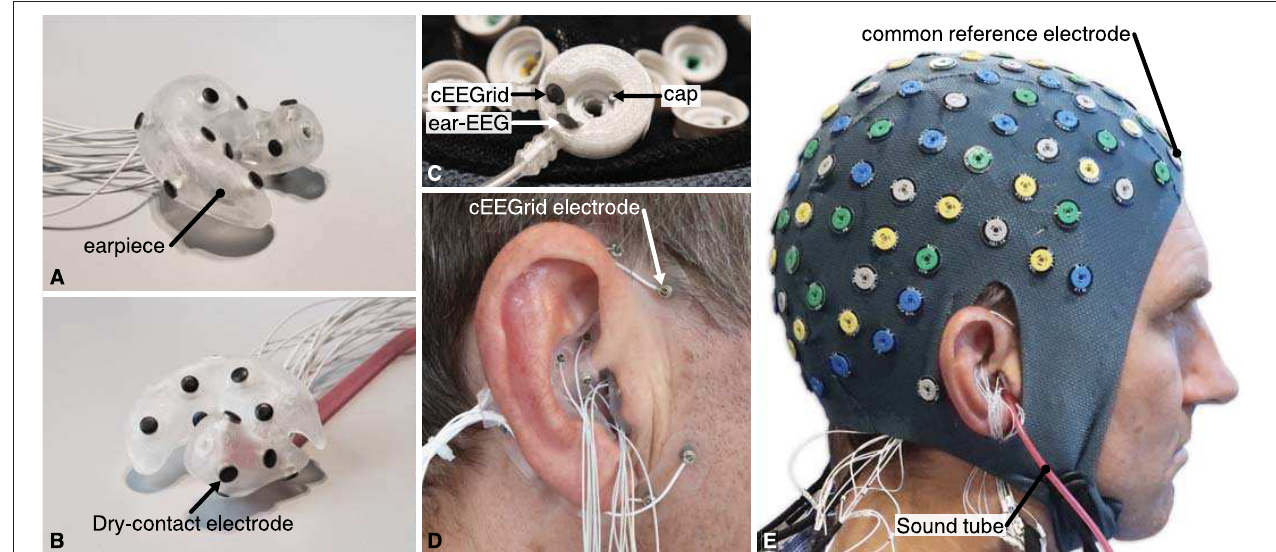
FIGURE 6 | (A,B) Example of a right ear-EEG earpiece with 15 dry-contact electrodes on the surface, shown from two different angles. The earpiece shown in (B) also have the sound tube mounted. (C) The custom-made common reference electrode, mounted at the FPz location in the headcap. (D) Earpiece mounted in the ear and cEEGrid around the ear. (E) The full experimental setup with cap, cEEGrid, and ear-EEG electrodes. The subject, depictured in (E) , has given written informed consent to the publication of the